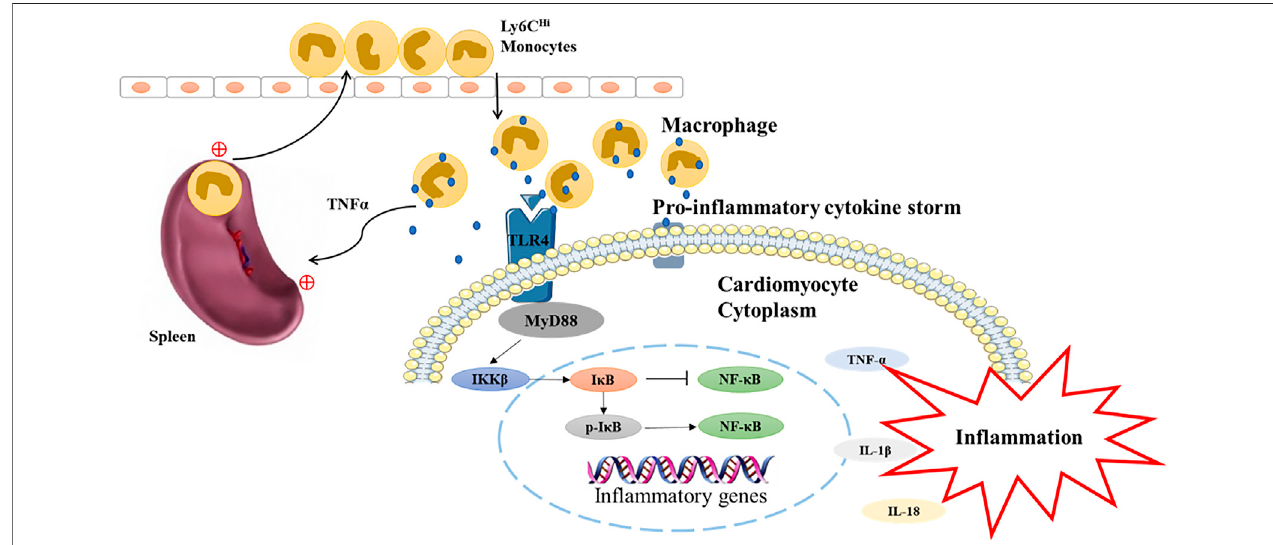
FIGURE 6 | The underlying mechanism of QSG in the treatment of heart failure is mediated by TLR4-MyD88-NF- κ B p65 pathway.